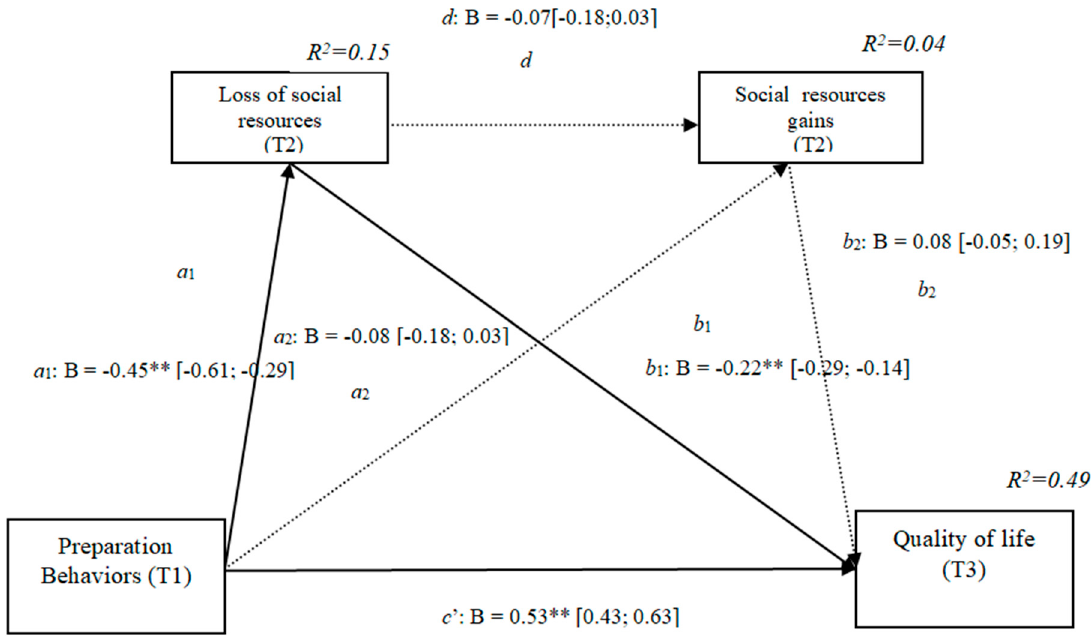
Figure 6. Non-standardized B coefficients, confidence intervals, and statistical significance for social gains and losses. [95% CI]; * p < 0.05; ** p < 0.01.